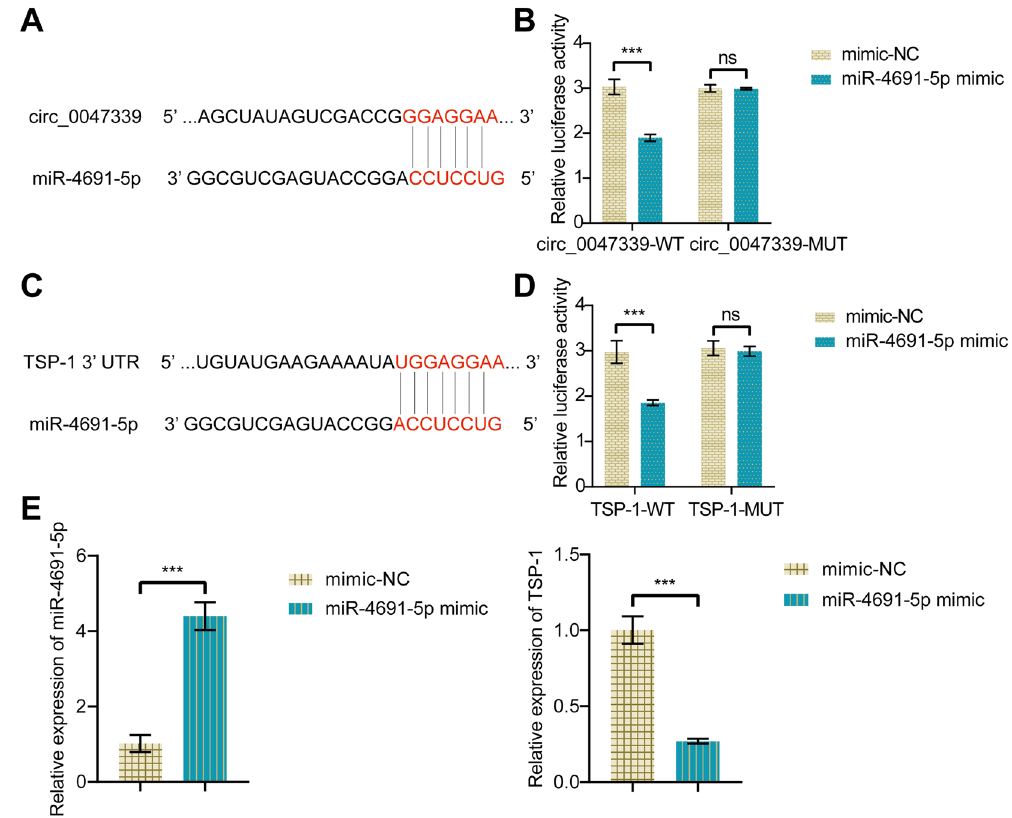
Figure 5. Circ_0047339 acts as a ceRNA in TSP-1 regulation by sponging miR-4691-5p. ( A ) The binding site of circ_0047339 and miR-4691-5p. ( B ) Dual-luciferase assay revealed the direct interaction of circ_0047339 with miR-4691-5p. ( C ) The binding site of miR-4691-5p and TSP-1. ( D ) Dual-luciferase assay revealed the binding of miR-4691-5p and TSP-1 3 ′ UTR. ( E ) RT-qPCR was used to detect the expression of miR-4691-5p and TSP-1. *P < 0.05, **P < 0.01, ***P < 0.001. ns no